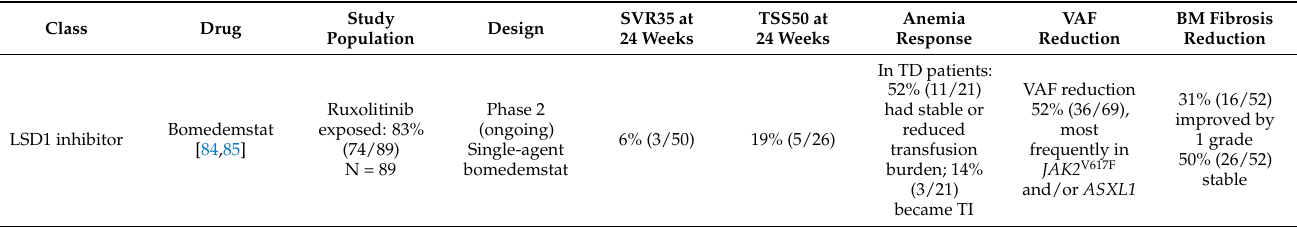
Table 1. Selected novel agents showing improvement in surrogate markers for disease modification in myelofibrosis, either as single agent or in combination with